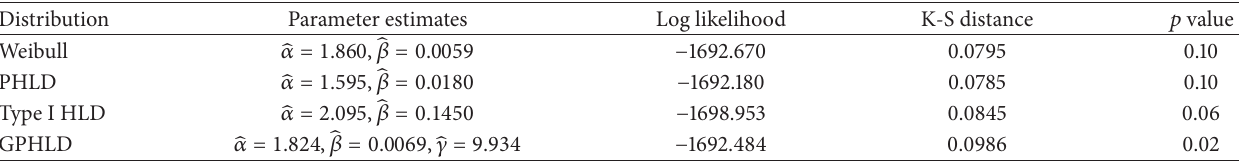
Table 7: Fitting based on data set